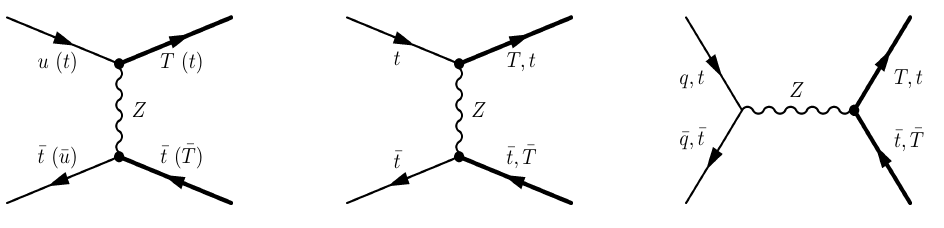
Figure 6 . Leading-order Feynman diagrams for the reaction pp ! T (cid:22) t + (cid:22) Tt in